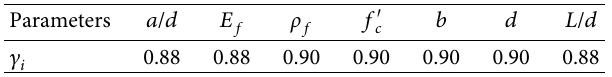
Table 4: Calculated value of the grey relational grade for each experimental